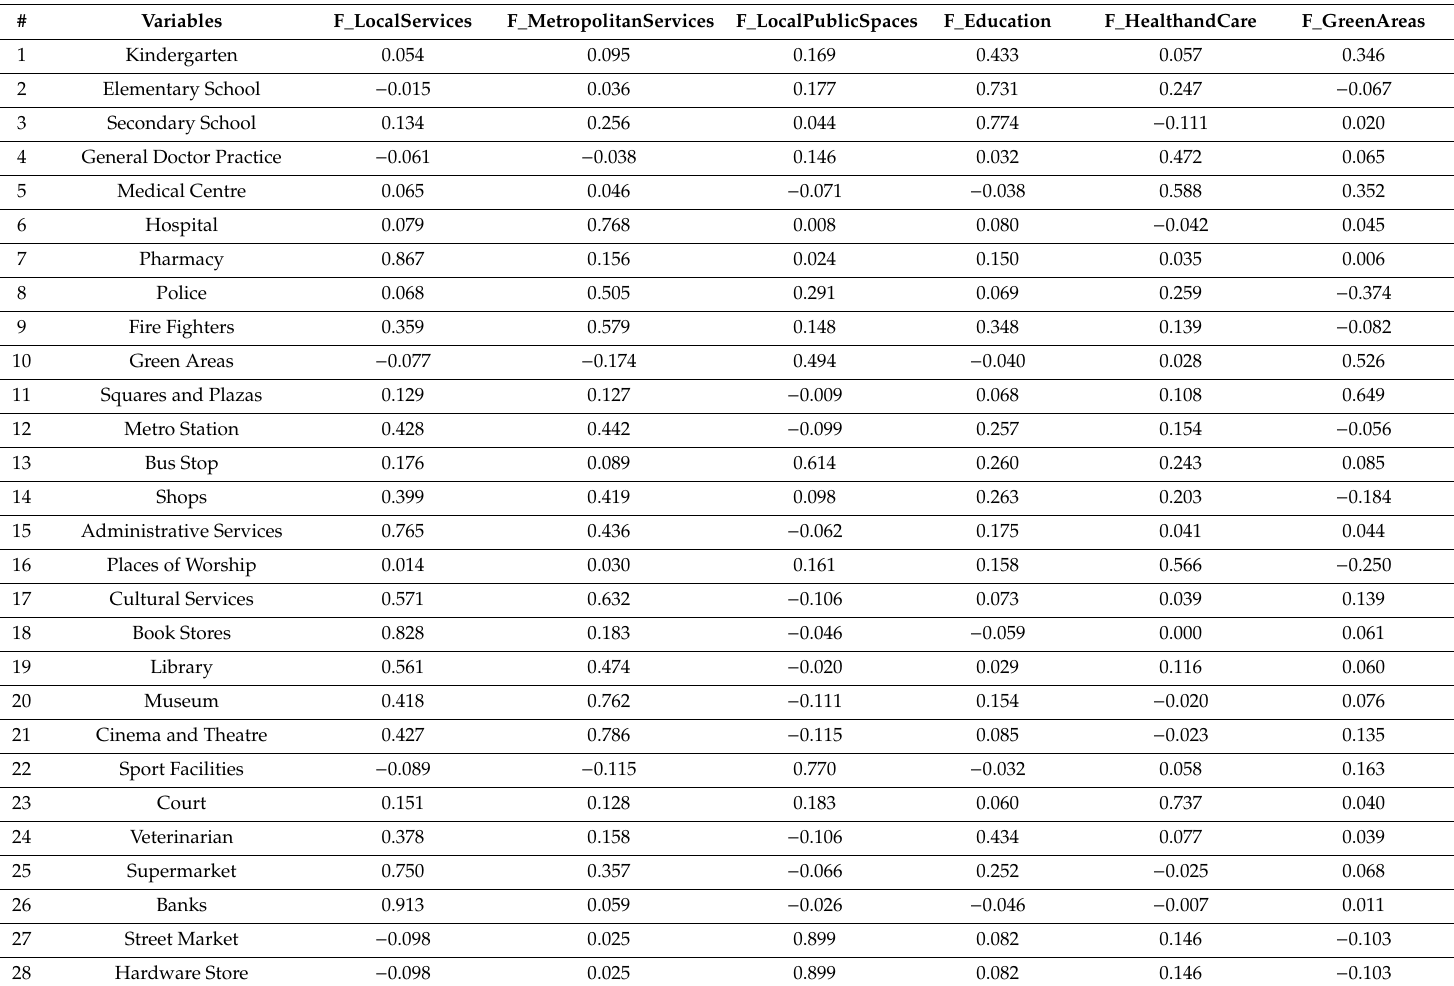
Table 3. Principal component analysis results per level based on the Varimax rotated scores. Source: